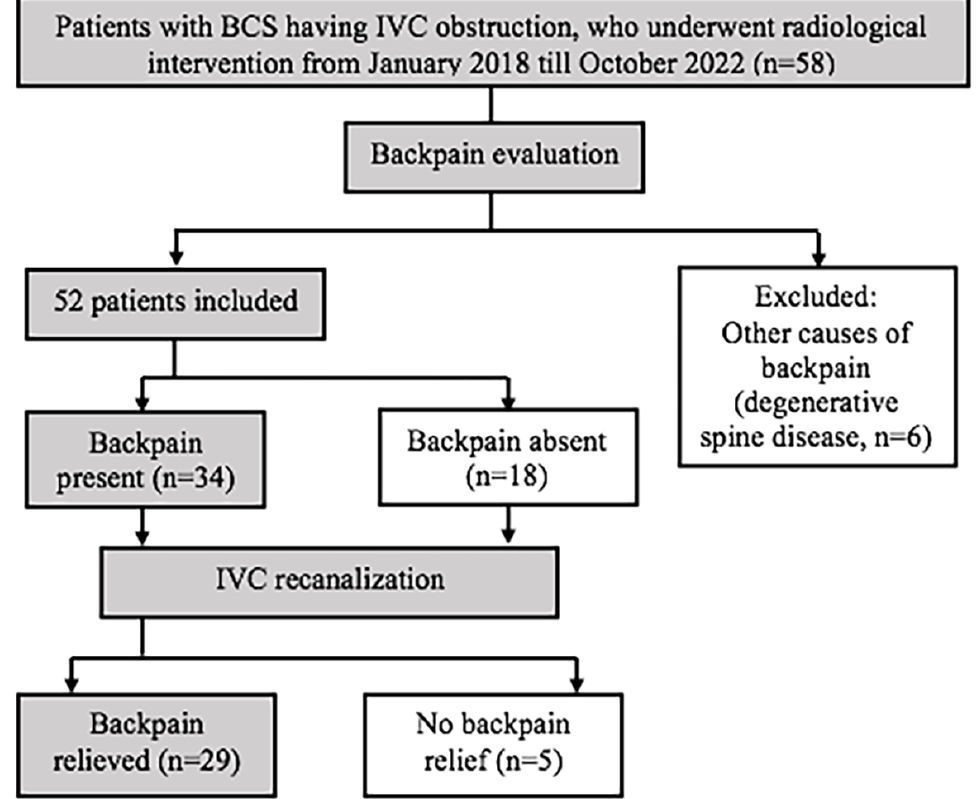
Figure 2. Study Figure 2. Study design. Table 1. Characteristics of study population.